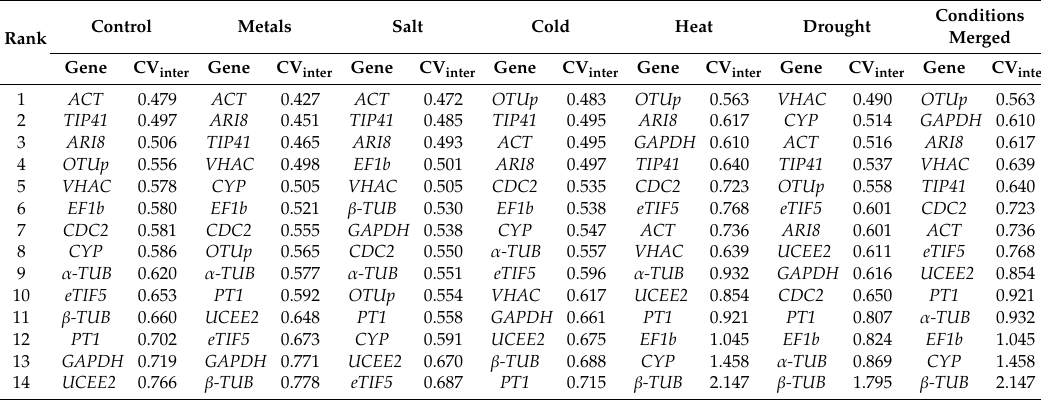
Table 6. Potential RGs to normalize qPCR data in Salix viminalis roots exposed to various abiotic stresses. Plants were exposed to the stresses for up to two months. Gene expression stability was calculated with GrayNorm. Genes are ranked according to their internal coe ffi cient of variation (CV inter ). Only single gene combinations are shown.